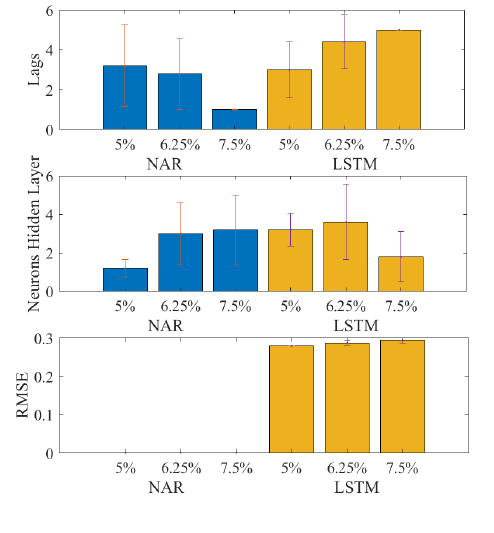
Figure 10. Resume of Results for the NAR and LSTM models in all simulation